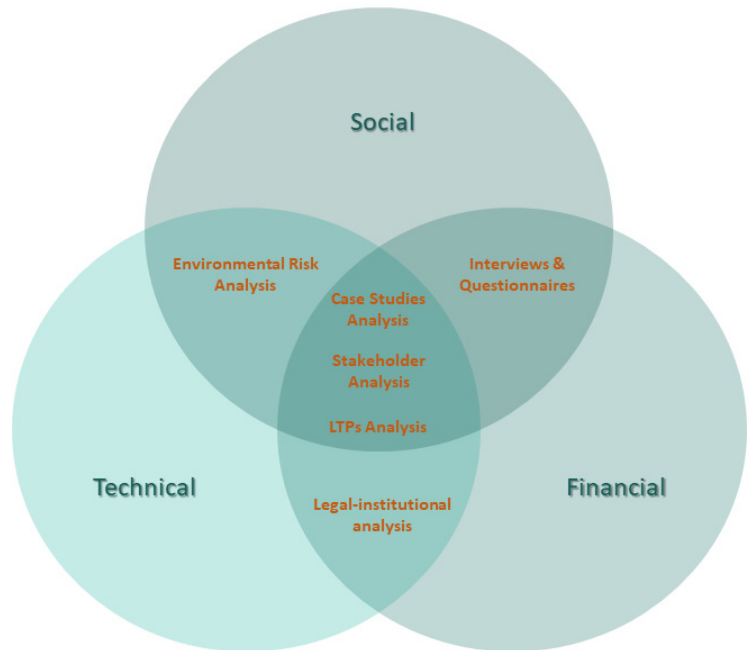
Figure 5. CROWDTHERMAL methodological interrelationships.